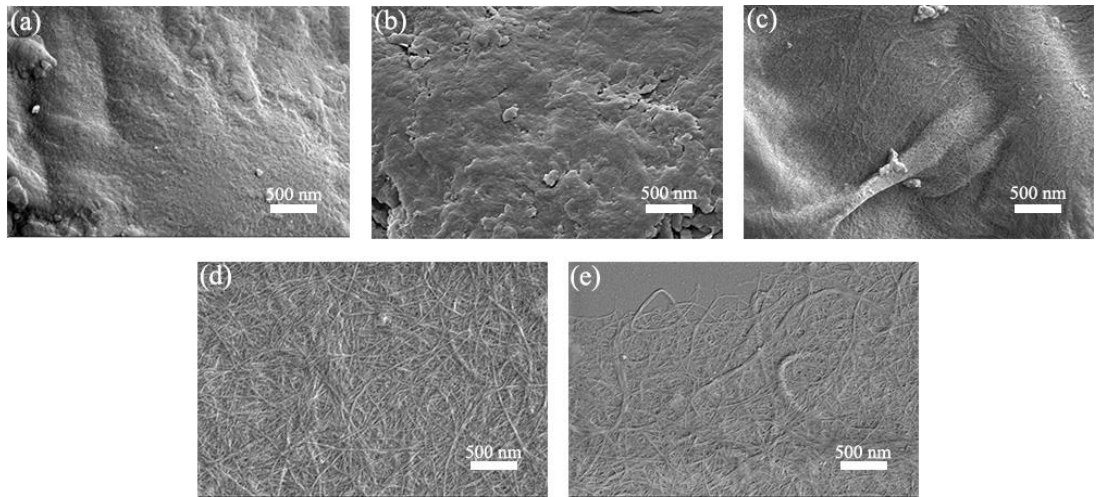
Figure 4. Scanning electron microscope (SEM) images of ( a ) SBP; ( b ) SBP-SC; ( c ) SBP-S; ( d ) SBP-S-B; and ( e ) SBP-S-B-H at 20,000 magnification. Materials 2018 , 11 , x FOR PEER REVIEW